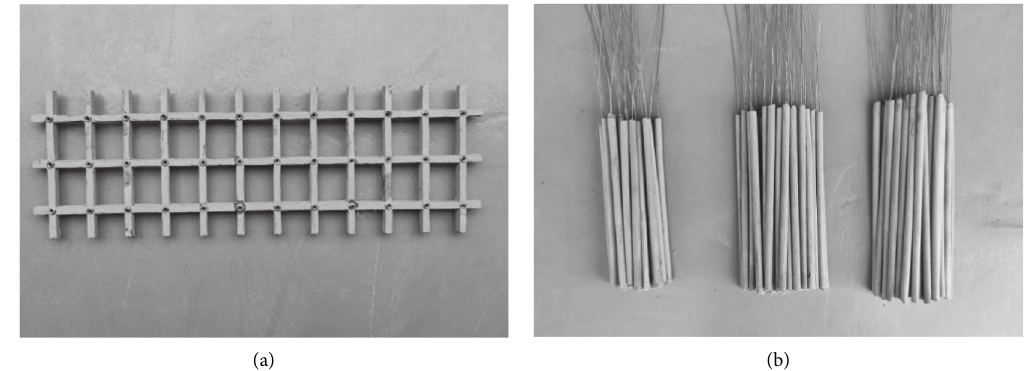
Figure 3: Fabrication of frame anchor structure. (a) Model frame. (b) Model